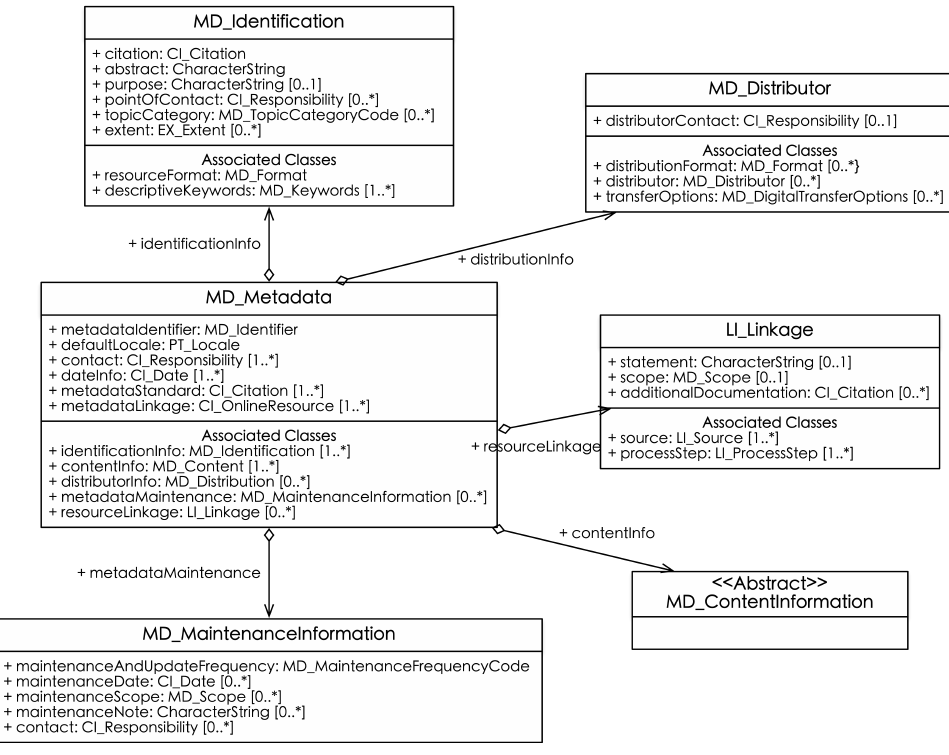
Figure 6. Standard-based IoT metadata